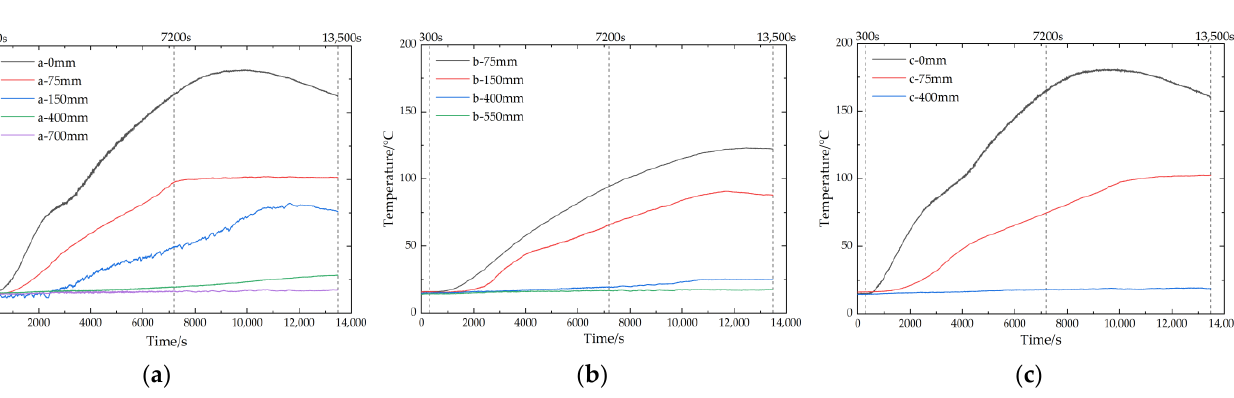
Figure 17. Temperature values of measuring points at each section under single-layer seam construction. ( a ) Section a; ( b ) Section b; ( c ) Section c.